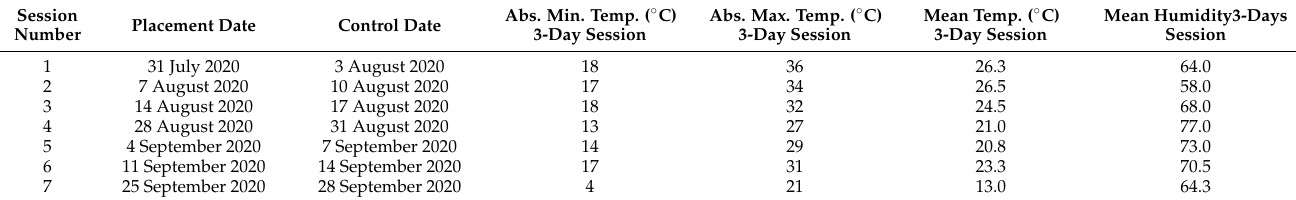
Table 2. Meteorological data obtained from the airport station for each of the three-days trapping